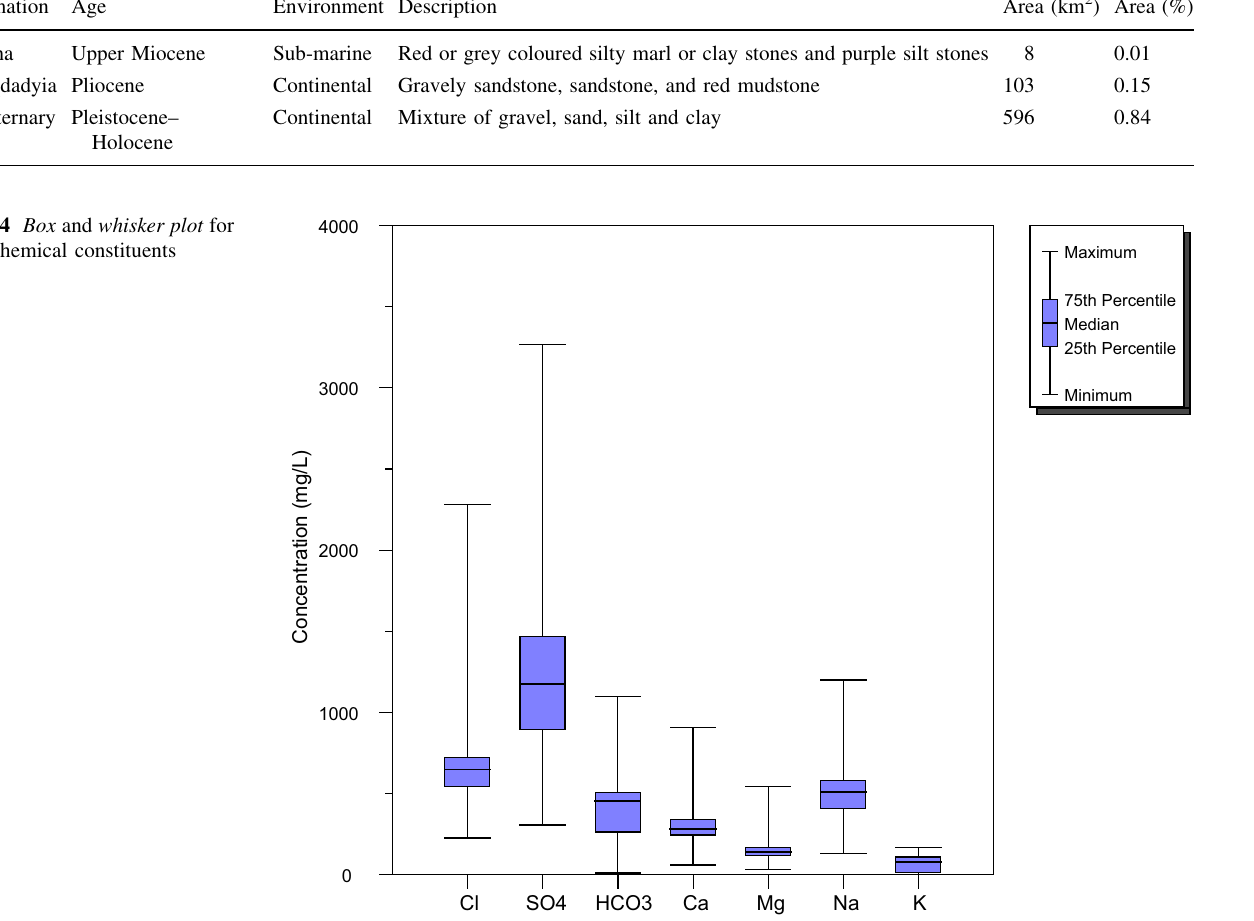
Table 1 Description of the lithological formations in the study area Formation Age